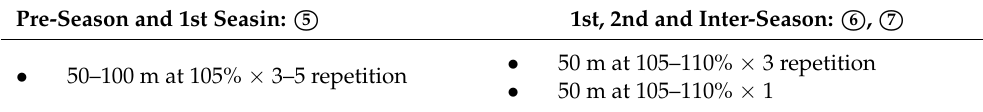
Table 2. Contents of Special sprint training for Supramaximal running in a small number of runs. Pre-Season and 1st Seasin: 5